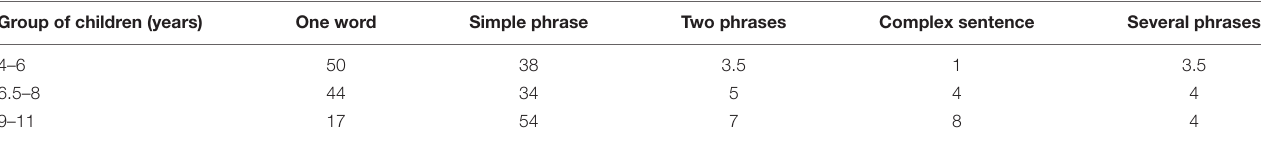
TABLE 2 | The structure of response replicas of children from three age groups in the dialogue with the adult (medians). Group of children (years)